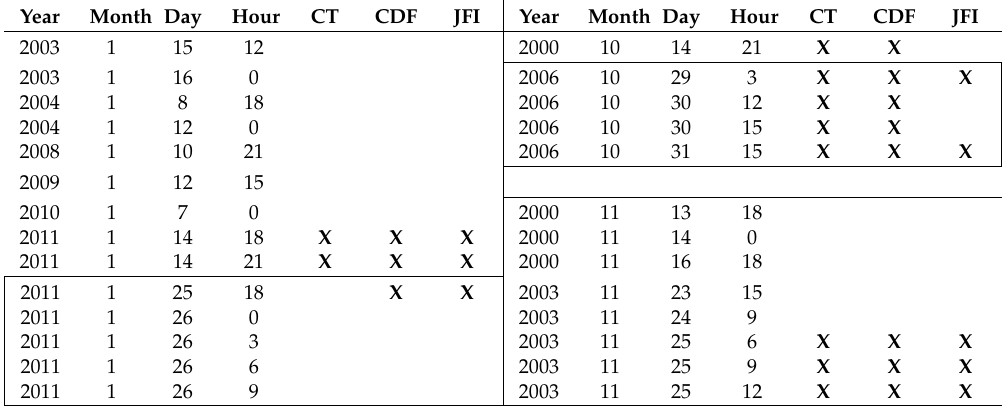
Table 5. Estimated flood dates and time (UTC) according to the constant threshold (10.37 mm/h), and updated cumulative distribution function and Jeddah flood